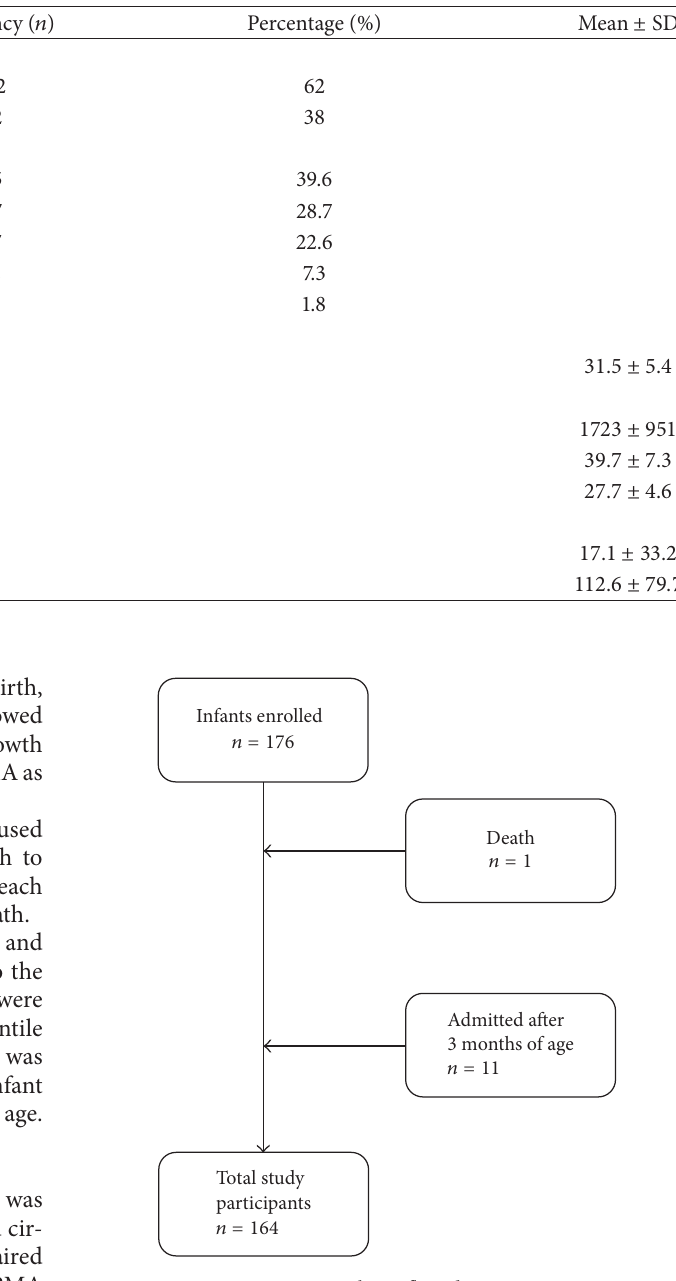
Figure 1: Subject flow